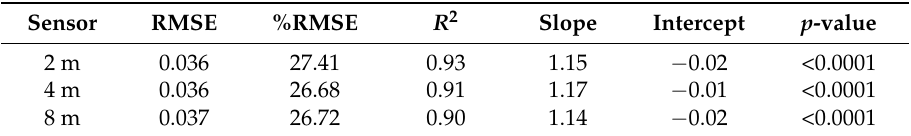
Table 2. Statistics from three eddy covariance systems evaluated against the lysimeter including root mean square error (RMSE), percent RMSE (%RMSE), correlation coefficient ( R 2 ), regression slope, regression intercept, and statistical p -value.